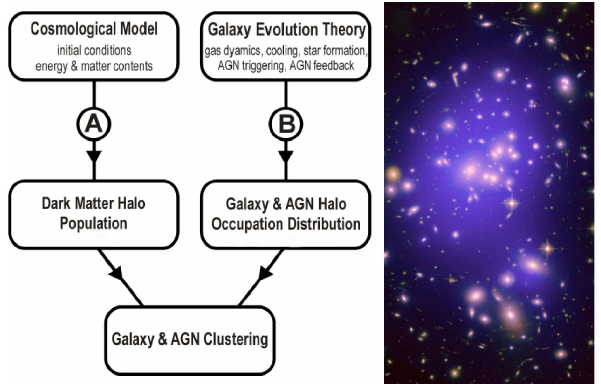
Figure 1: Current conceptual model of the physical processes involved in large-scale galaxy and AGN clus- tering. Left: The two branches (A and B) in the di- agram show the primary causes of clustering: (A) the properties of the dark matter halo population, which are based on the cosmological model, and (B) the physics of complex processes in galaxy formation and evolution, which lead to a distinct baryonic population within col- lapsed dark matter halos. Figure adapted from Wein- berg 2002. Right: Illustration of the spatial distribution of galaxies within a dark matter halo. The picture maps the galaxy cluster Abell 1689, where an optical image showing the galaxy cluster members is superimposed with the distribution of dark matter shown in